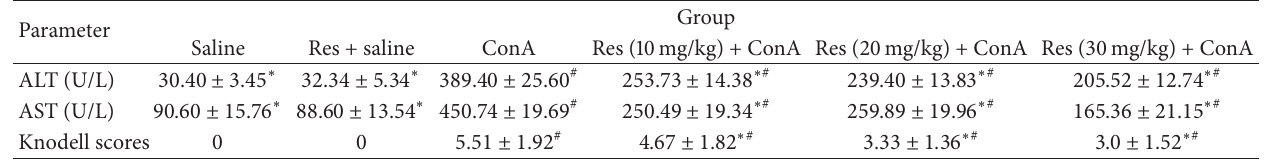
Table 1: Effect of resveratrol on serum biomarkers and Knodell